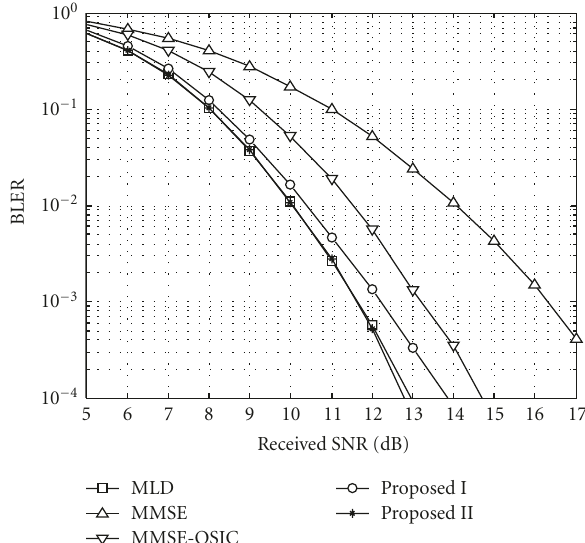
Figure 10: Comparison of the BLER performance of the first PSS for the proposed and the conventional schemes when the MCS combination is { (16 QAM, 1/2), (QPSK, 1/2) } .